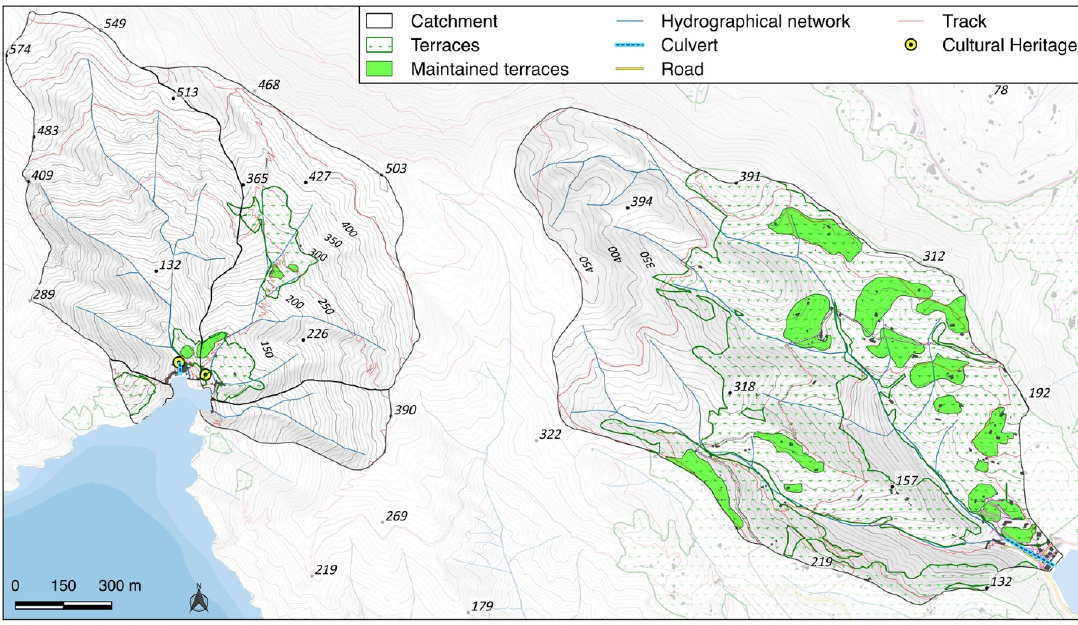
Figure 6. The detected terraces after Sky View Factor computation.